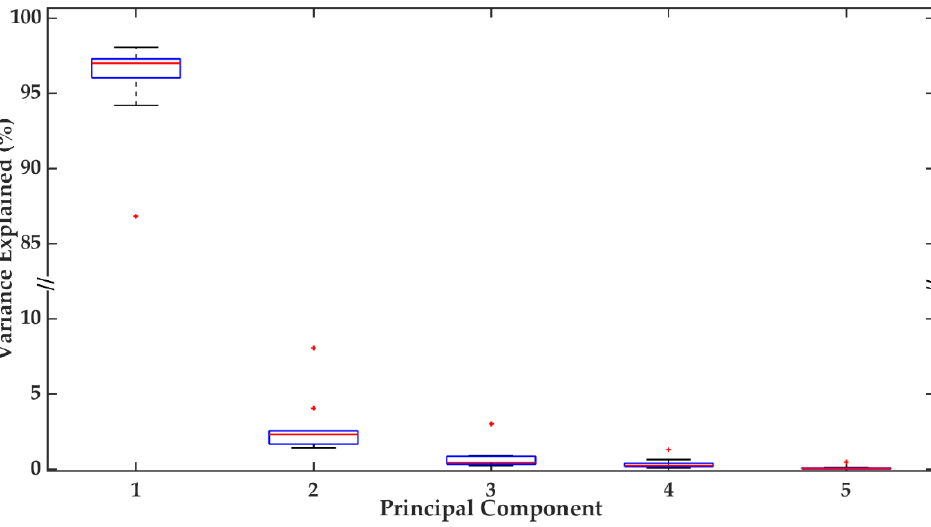
Figure 5. The first five PCs in PCA of BT HRV features.